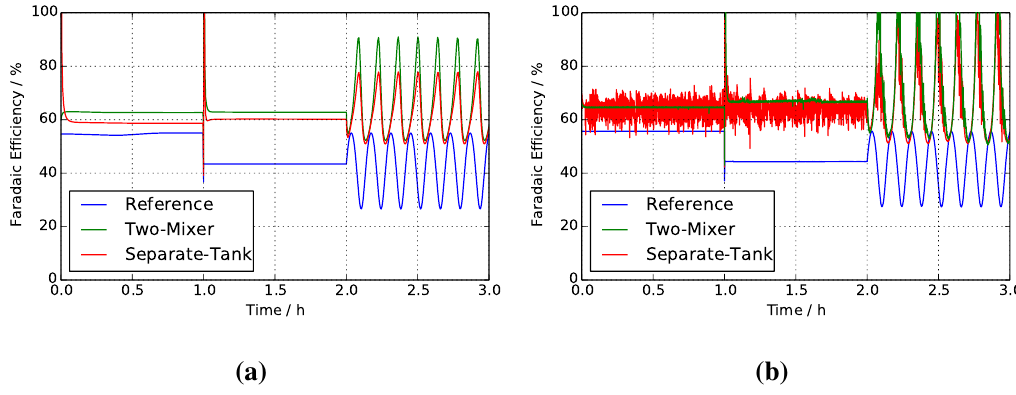
Figure 11. Faradaic efficiencies of the various systems in simulations and experiments. ( a ) Simulations; ( b )